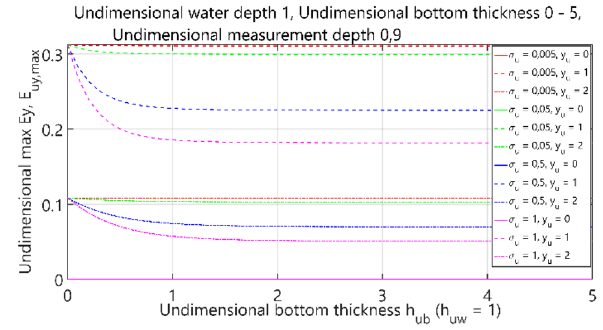
Figure 38. Dependence of E uy,max on h ub .